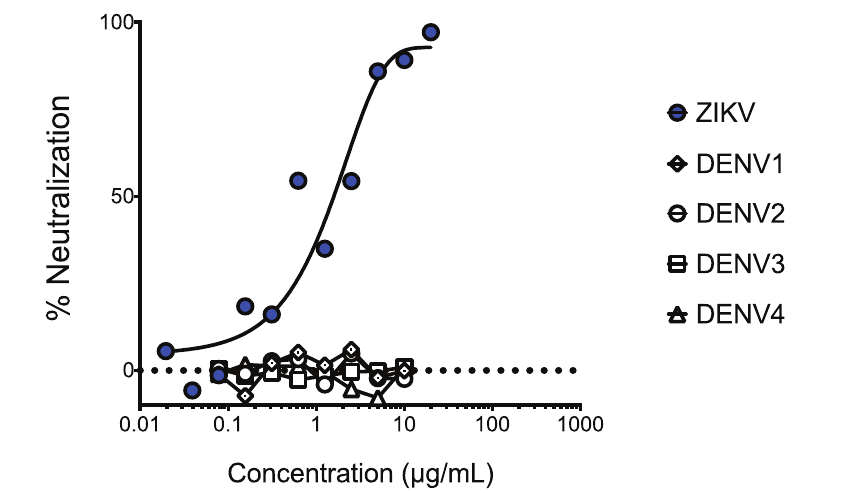
Fig 2. P1F12 mAb neutralizes ZIKV. P1F12 neutralization curves are presentedas the reductionof Vero- cell infectivity measuredby flow cytometry.